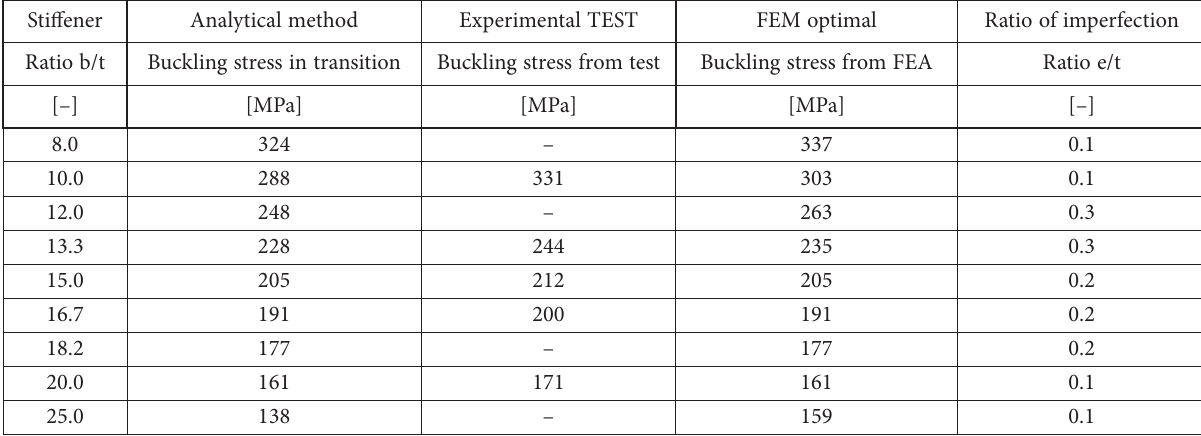
Figure 11. Complex comparison of results of various sets profile dimensions Table 4. Comparison of results gained by analytical methods and experimental